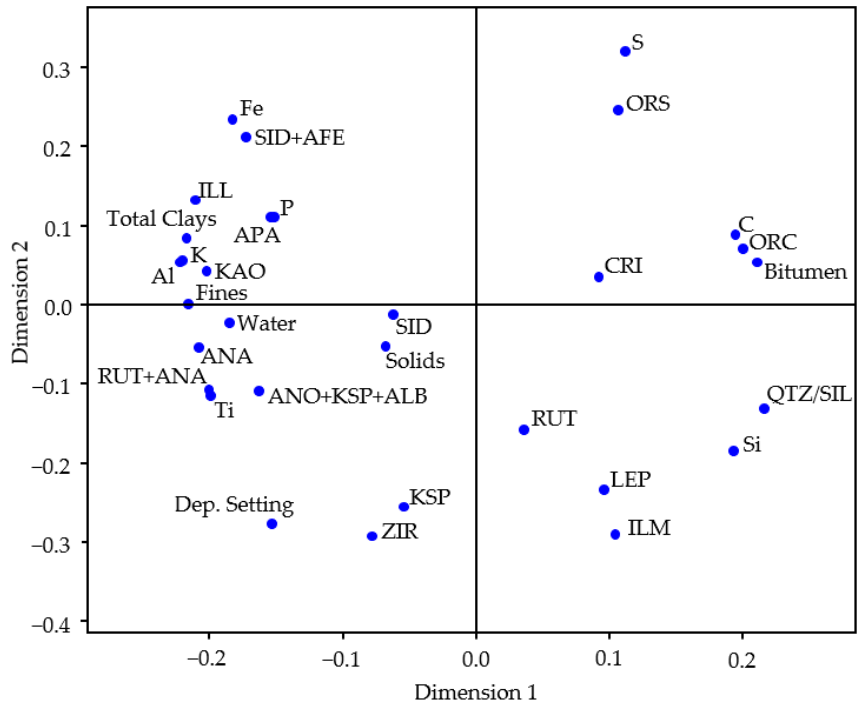
Figure 8. Plot of the 𝐗 variable loadings (matrix 𝐏 ) for the first two components (dimensions 1 and